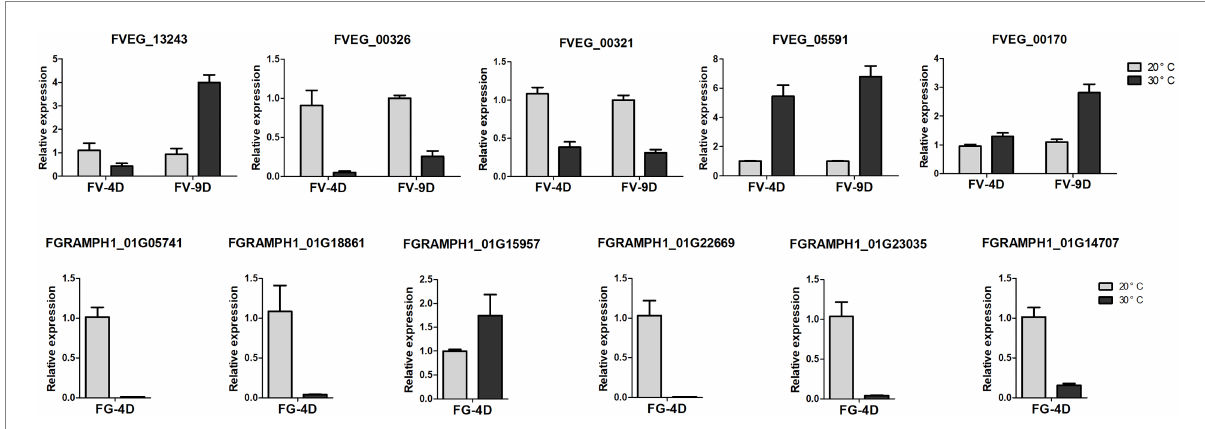
FIGURE 6 The relative expression levels of differently expressed genes detected by qRT-PCR. The data were obtained from three biological replicates and Actin of F. verticillioides and GAPDH of F. graminearum were used as the internal reference. FV-4D: F. verticillioides cultivated for four days, FV-9D: F. verticillioides cultivated for nine days. FG-4D: F. graminearum cultivated for four